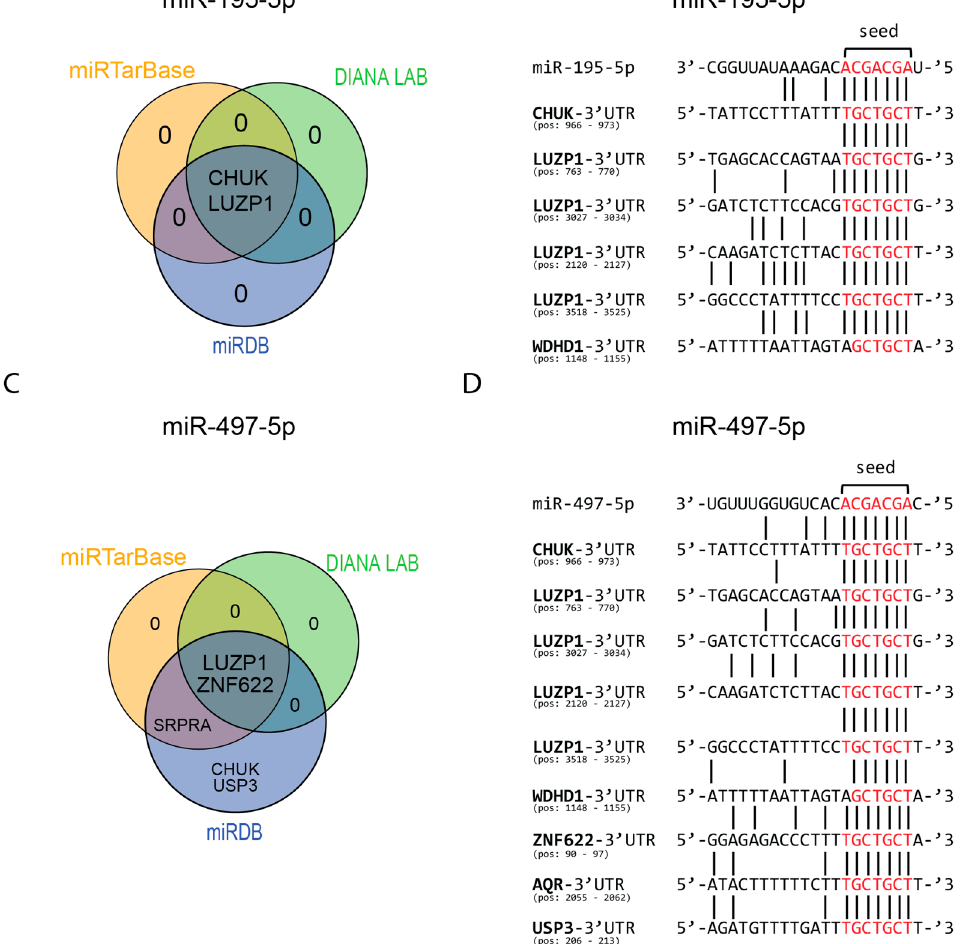
Figure 5. miRNA target evidence of differential expressed proteins from the proteomics screen. Venn diagram of mRNA target evidence found in the different databases for miR-195-5p ( A ) and miR-497-5p ( C ). mRNA target sites of potential targets of miR-195-5p ( B ) and miR-497-5p ( D ) based on the seed sequence (given in red).